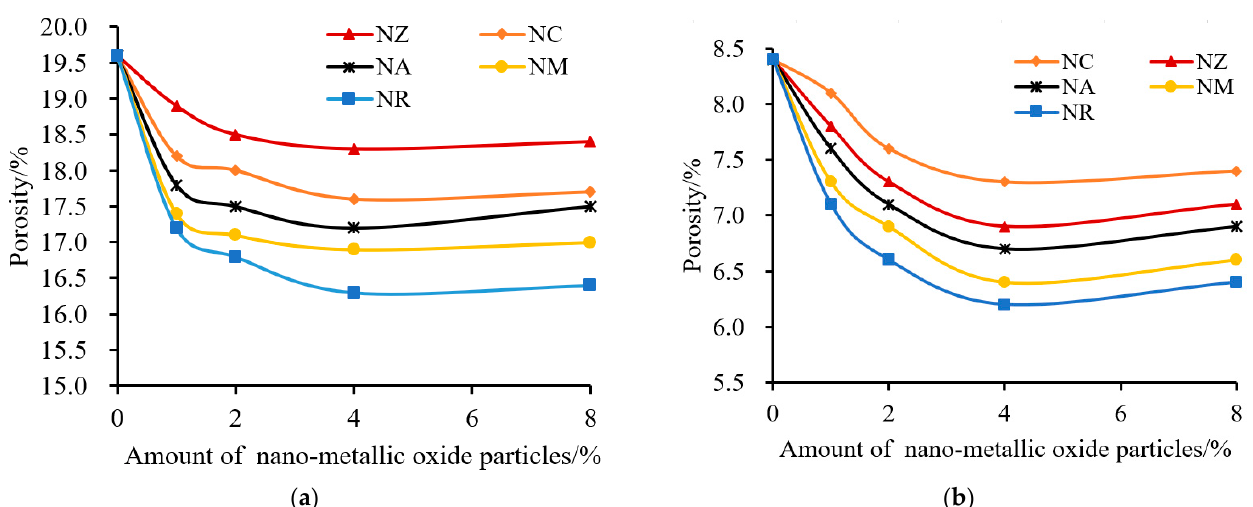
Figure 5. Porosity of cement mortar with nano-metallic oxide particles: (a) 28 days; (b) 730 days.